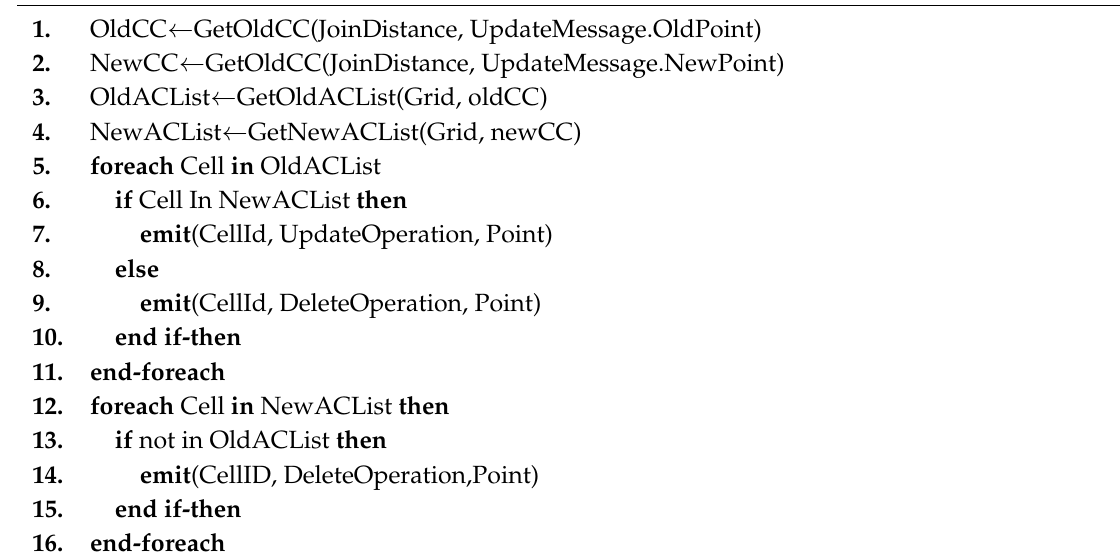
Algorithm 1: UpdatePartBolt (Tuple UpdateMessage)